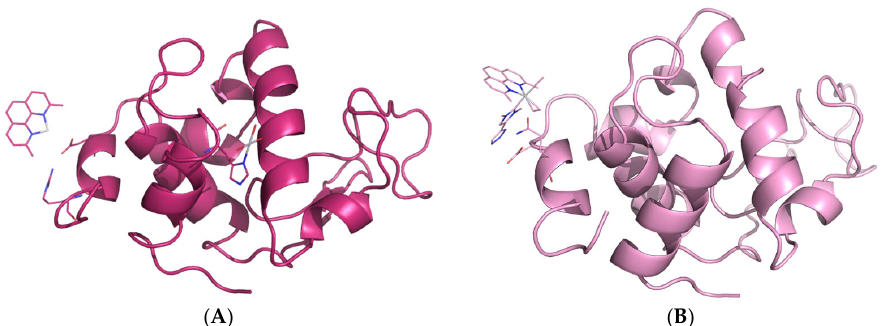
Figure 8. Overall structures of the adducts formed upon the reaction of 1 ‐ Me,Me with HEWL in 20% ethylene glycol, 0.1 M sodium acetate buffer at pH 4.0, and 0.6 M sodium nitrate (Structure A ) and in 2.0 M sodium formate and 0.1 M Hepes at pH 7.5 (Structure B ).